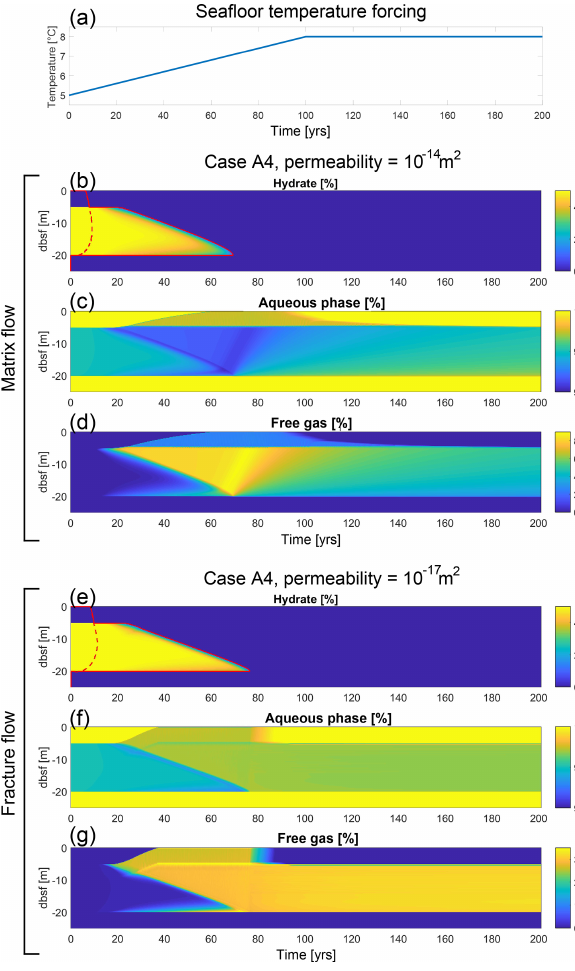
Figure 4. (a) Model simulations are all forced by a linear seafloor temperature increase of 3 ◦ C over the first 100 years. Modelled hydrate saturation (b, e) , aqueous saturation (c, f) and gas satura- tion (d, g) as a function of time and depth b.s.f. for two simulations (Case A4) with permeability of 10 − 14 m 2 (b–d) and 10 − 17 m 2 (e– g) , respectively. Also shown in panels (b) and (e) is the GHSZ, where the solid red line indicates the boundary for unstable con- ditions and the dashed red line indicates the boundary for stable conditions (area in between is at the melting point). The pressure development and the phase transition boundary at different times are shown in Fig.